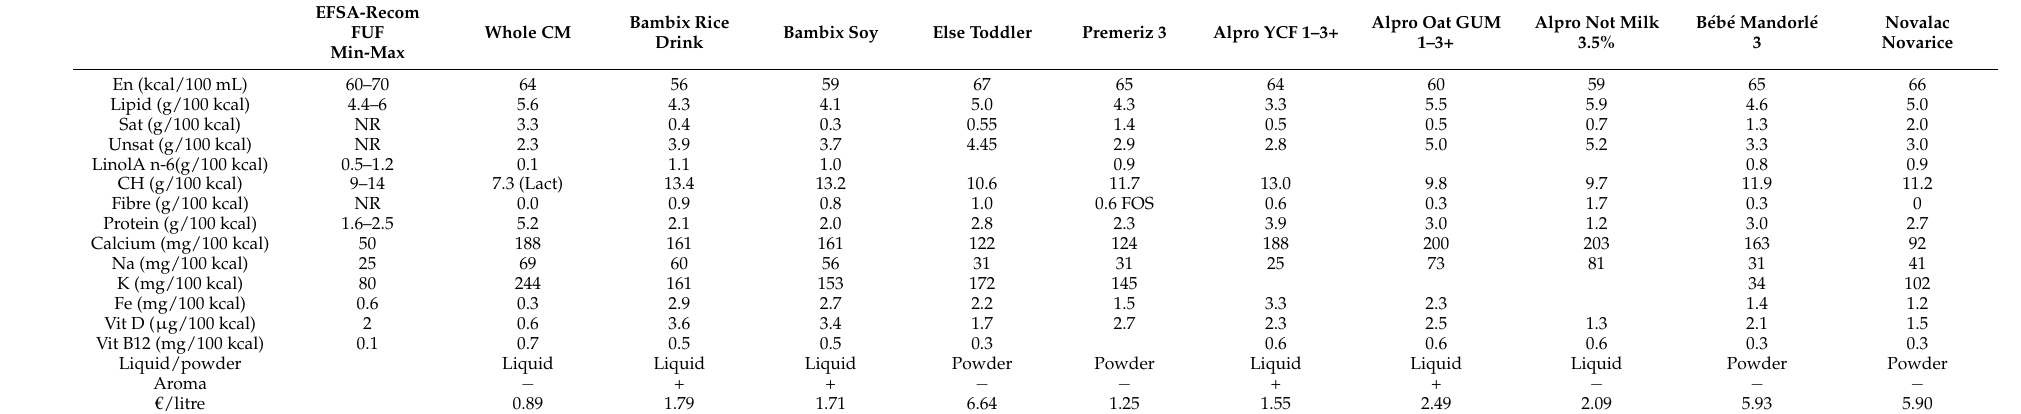
Table 2. Composition of some plant-based drinks and liquid feeding for